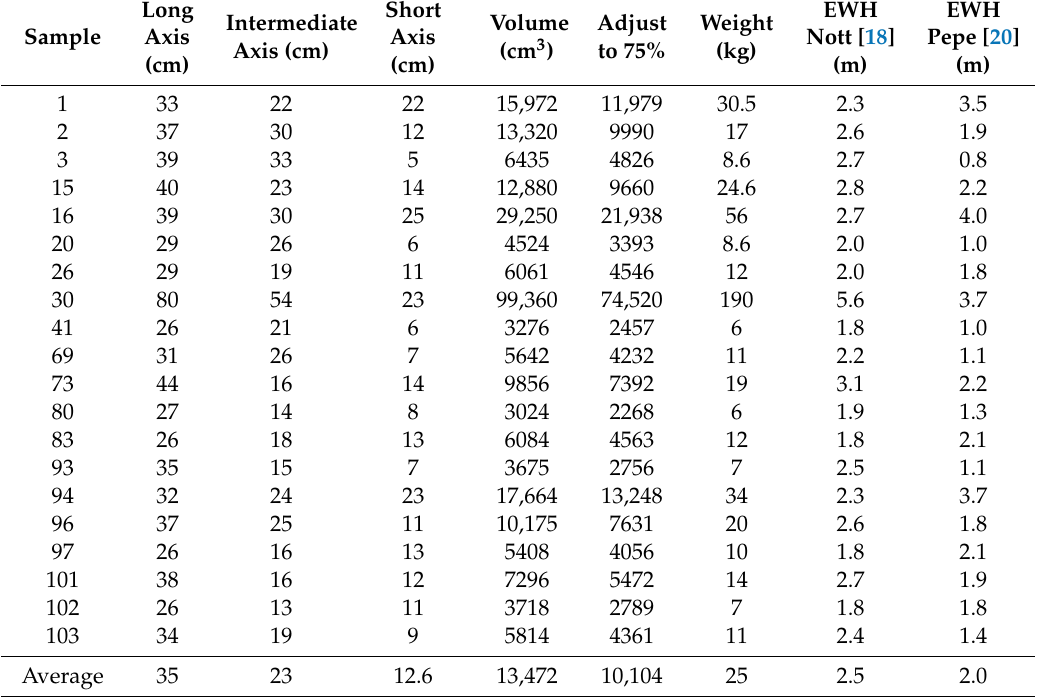
Table A6. Quantification of boulder size, volume, and estimated weight from all coastal bar boulders through transect 6 at Bah í a San Luis Gonzaga. EWH = estimated wave height. The density of Baja Californian andesite at 2.3 gm / cm 2 is applied uniformly in order to calculate wave height for each